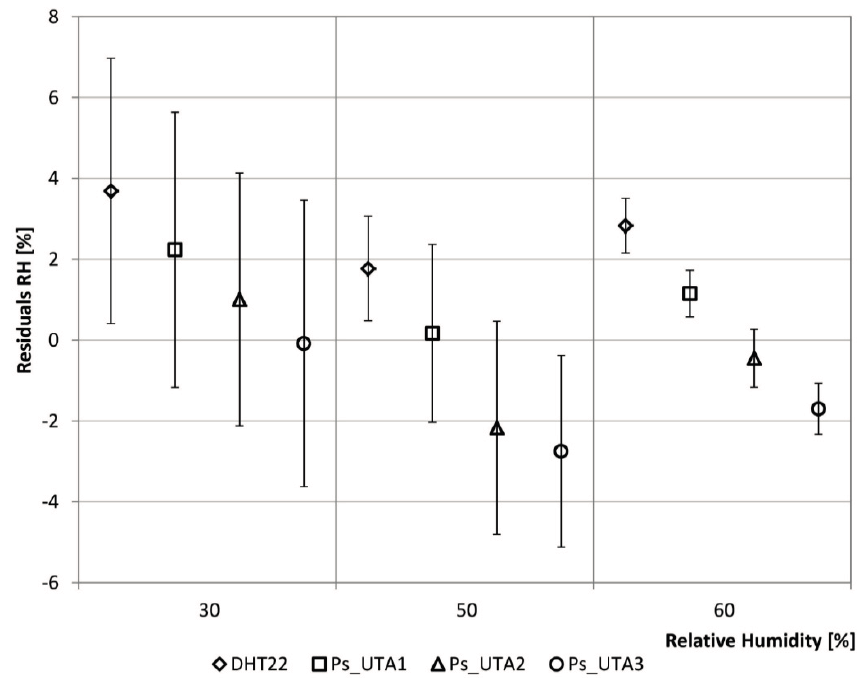
Figure 4. Residuals analysis of the relative